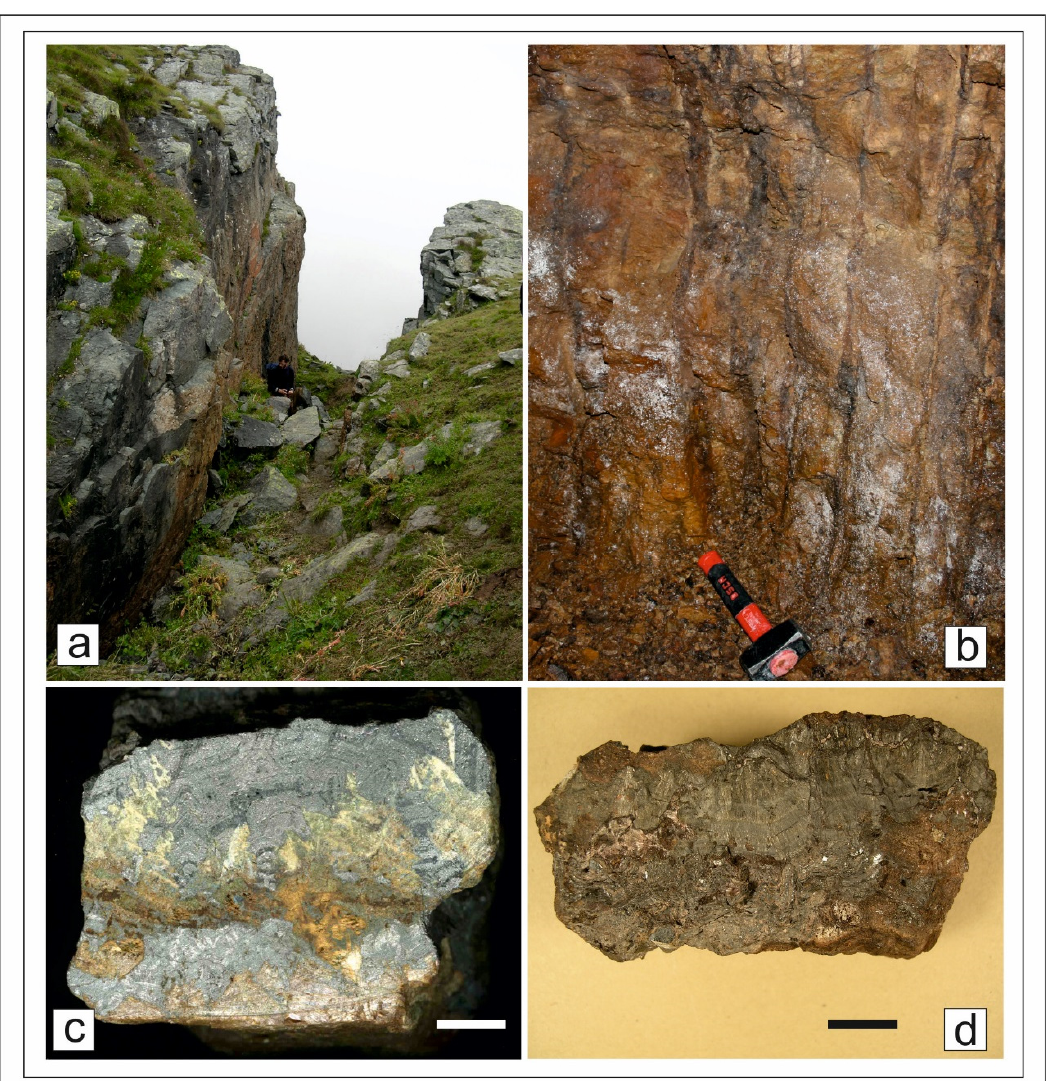
Figure 9. Usseglio vein system: ( a ) morphological depression due to the mining excavation for iron along the main siderite-rich vein (“Taglio del Ferro”); ( b ) underground exposure of a main siderite-rich vein along the crosscut at 2374 m. The “vein” actually consists of a series of subparallel, centimeter- to decimeter-thick veins crosscutting strongly altered metabasites. ( c ) and ( d ): hand samples of the Co–Ni–Fe arsenides mineralization, ( c ): coarse-grained skutterudite (metallic grey) showing crystal growth structures, scale bar: 1 cm; ( d ): coarse-grained, fan-shaped rammelsbergite, scale bar: 2 cm.